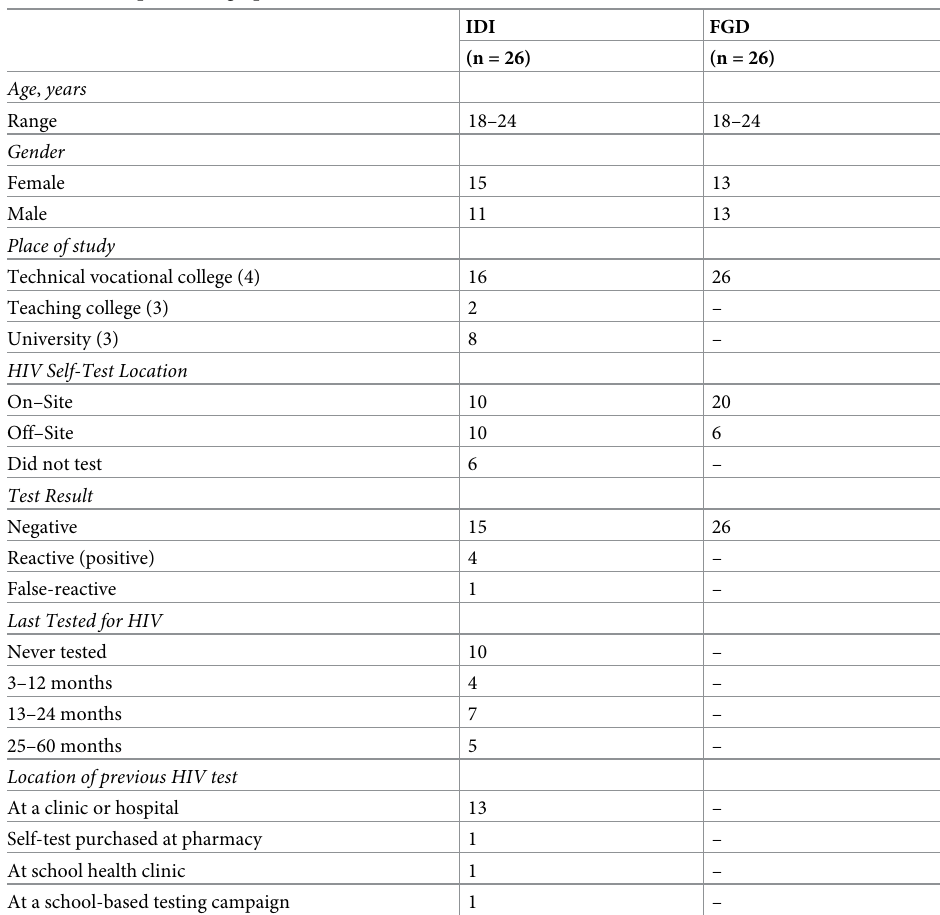
Table 2. Participant